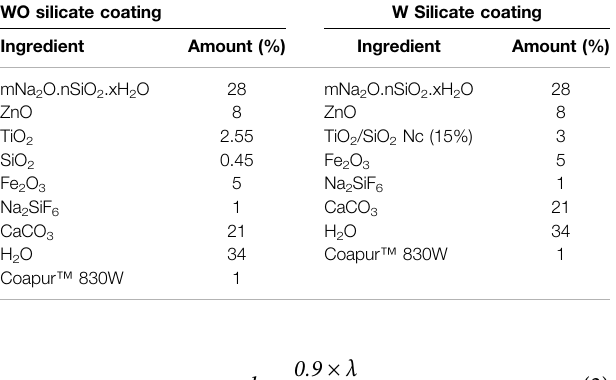
TABLE 1 | The formulations of the WO silicate coating and W silicate coating. WO silicate coating W Silicate coating Ingredient Amount (%) Ingredient Amount (%)